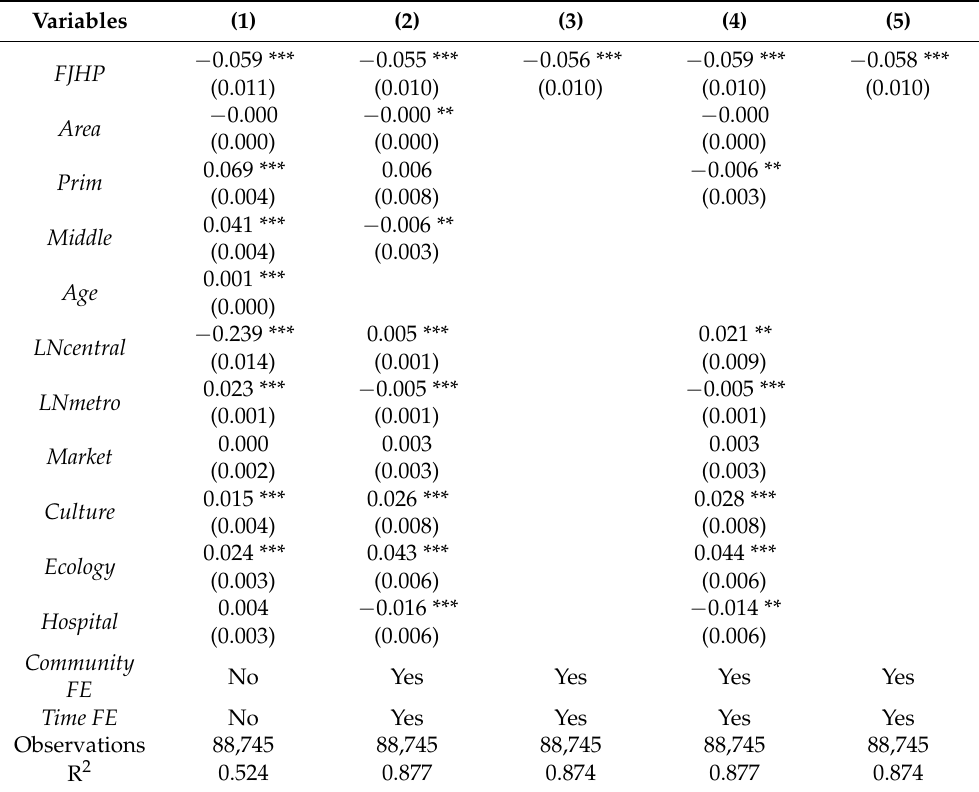
Table 4. Effect of the FJHP on housing prices in the FJHP school